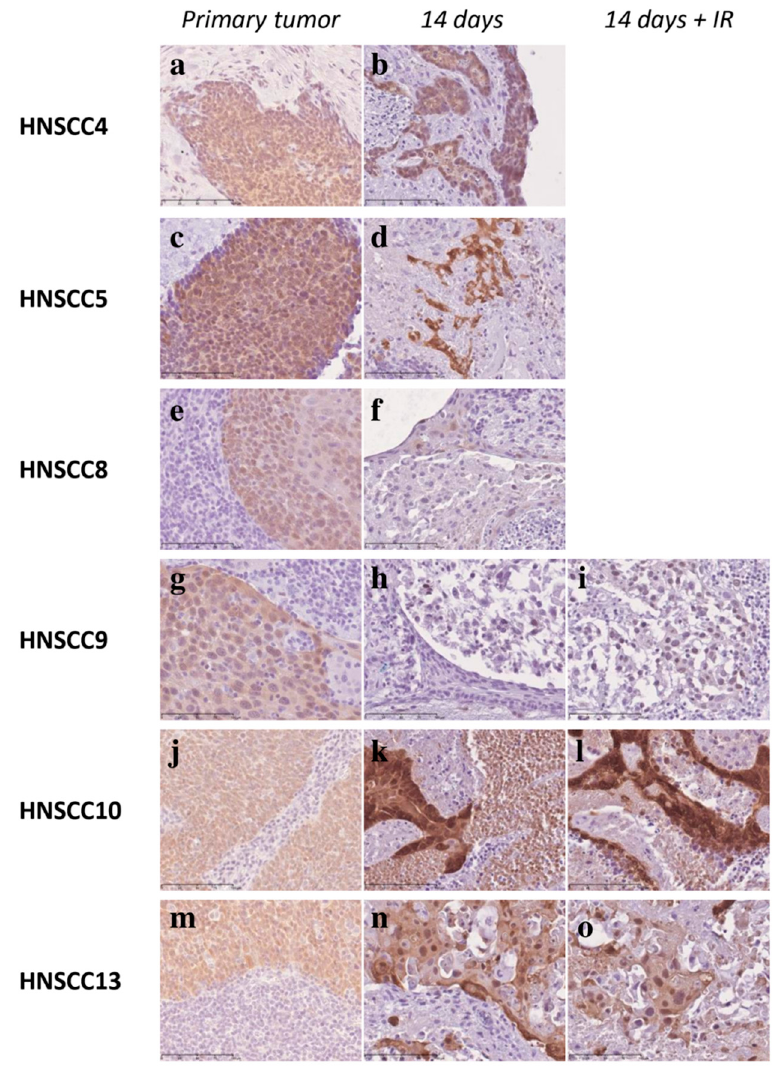
Figure 8. Representative images of an IHC, performed with an anti-p16 INK4a -antibody, of all six cultured HPV-driven 3D-OTC on day 14 ( b , d , f , h , k , n ), according primaries ( a , c , e , g , j , m ) as well as according 3D-OTC on day 14, treated with fractionated irradiation (IR) ( i , l , o ). While p16 INK4a was stably expressed in unirradiated HNSCC4, 5, 10, and 13 up to day 14, there was a strong decrease of expression in HNSCC8 and 9. P16 INK4a expression does not di ff er between irradiated and non-irradiated 3D-OTC on day 14. Scale Bar: 100 µ m. Abbreviations: HPV, human papillomavirus; 3D-OTC, 3D organotypic co-culture; IR fractionated irradiation.